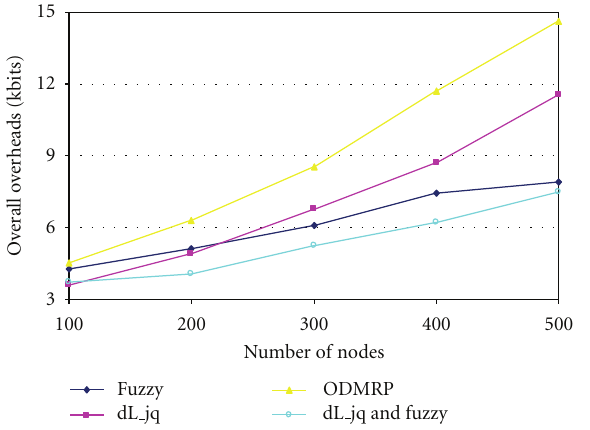
Figure 16: Number of received packet with increasing packet interval time.